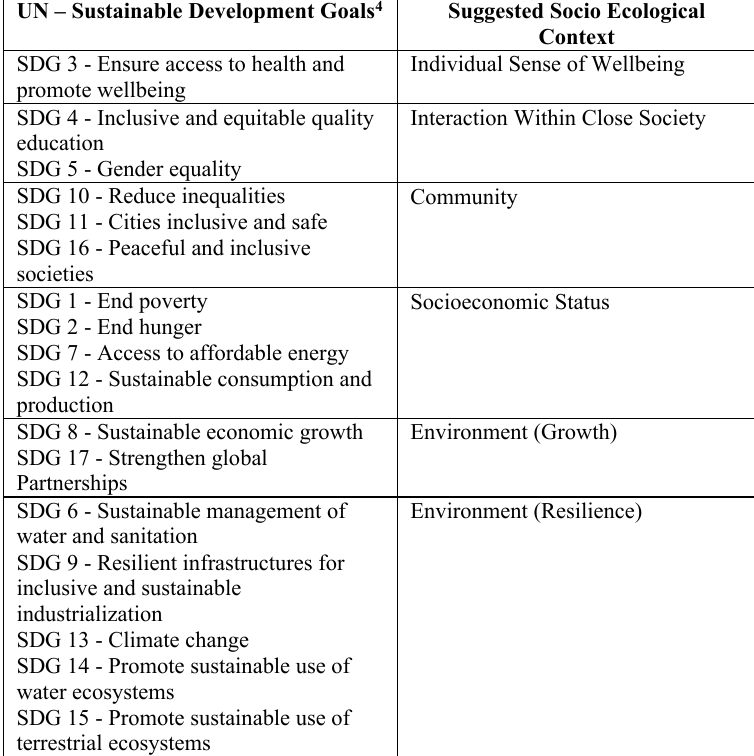
Table 1. The concept of socio ecological context and the